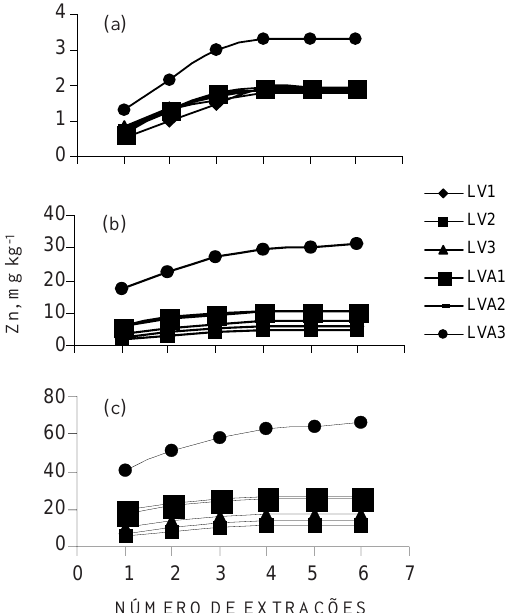
Figura 1. Dessorção cumulativa de zinco, em extrações sucessivas com resina de troca catiônica, em seis solos sem calagem e